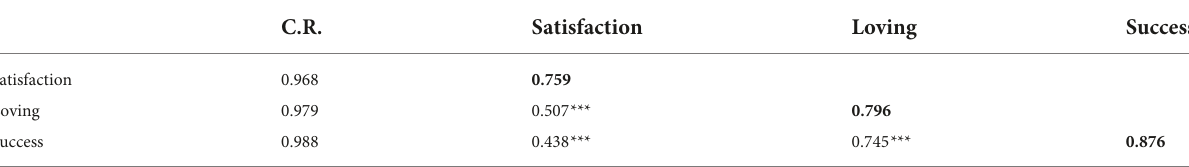
TABLE 4 Composite reliability and discriminant validity of the factors.